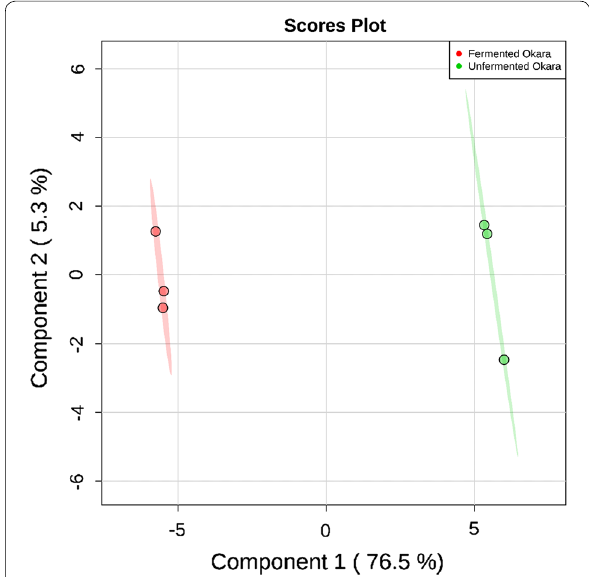
Fig. 1 PLS-DA score plot of all metabolites found for fermented and unfermented okara. The green and red highlights denoted the 95% confidence region. Explained variance are shown in